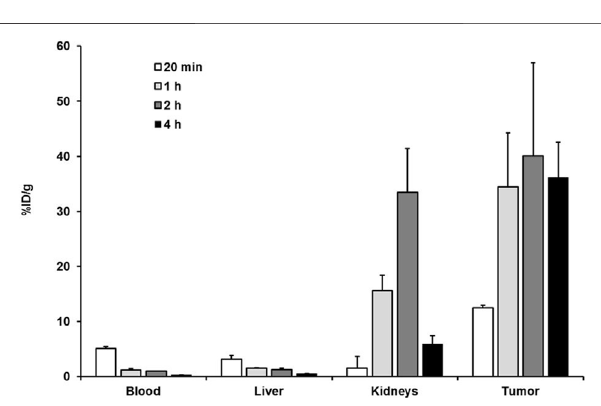
FIGURE 5 | Organ distribution of 68 Ga-CA028 (0.05 nmol, 20 MBq) expressed as % ID/g of tissue ±SD ( n = 3) at 20 min and 1, 2, and 4 h post injection.